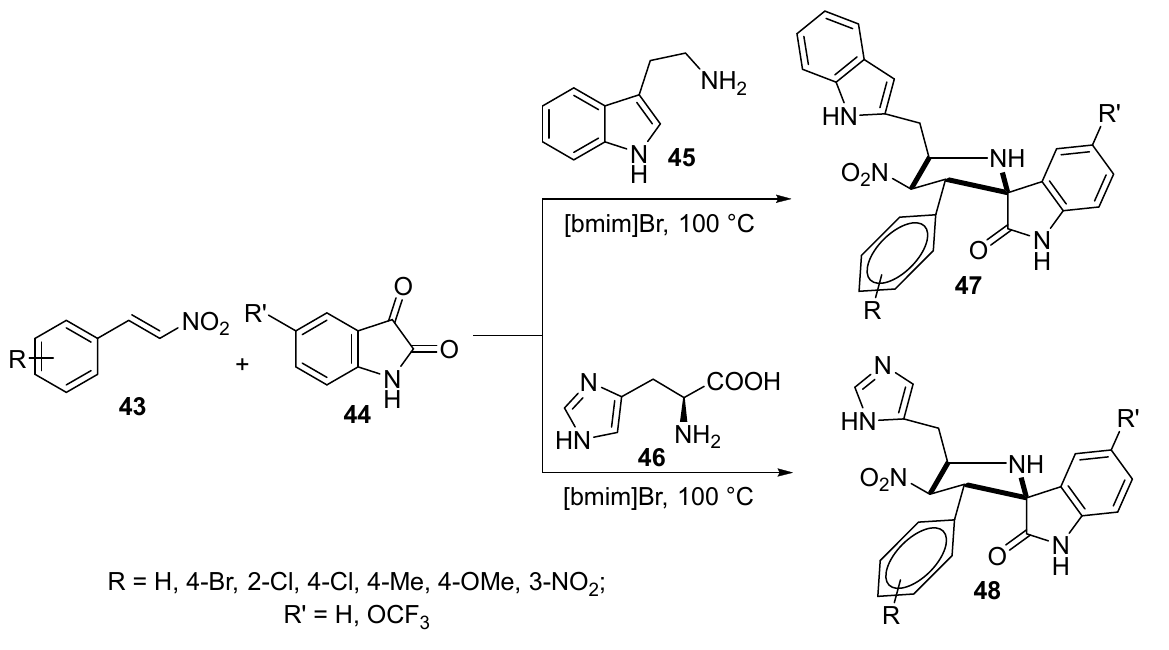
Scheme 8. Synthesis of spirooxindolopyrrolidines 47 and 48